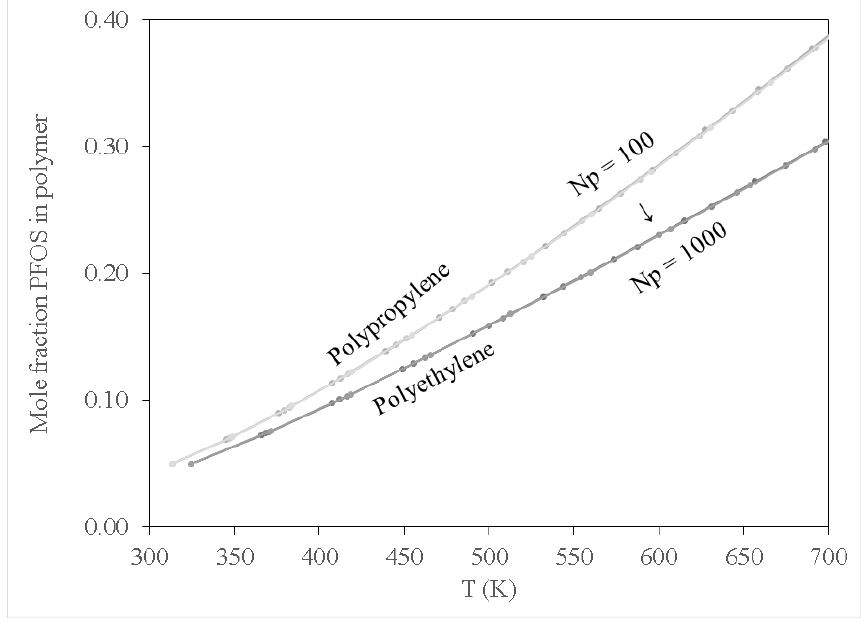
Figure 3. Effect of temperature on PFOS content of PP and PE with respect to the degree of polymer- isation (Np).